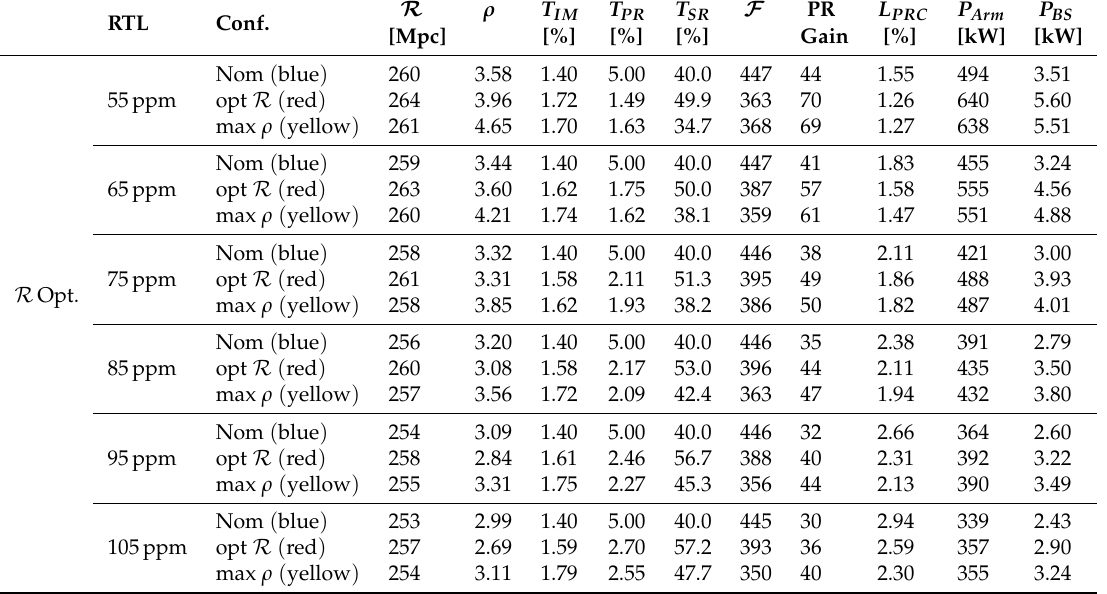
Table A1. Optimization results for six values of round trip losses for the two primary parameters R and ρ . Shown are the configurations for optimal R ( ρ ), maximum ρ ( R ) within ± 3Mpc ( ± 15 SNR) of the optimal primary parameter, and nominal configurations, where colours indicated correspond to curves plotted in Figures 5 and 6 Also shown are the corresponding Finesse ( F ), power recycling gain ( G PR ), PRC losses ( L PRC ), arm cavity power ( P Arm ), and power impinging on the beam splitter ( P BS ). RTL Conf.